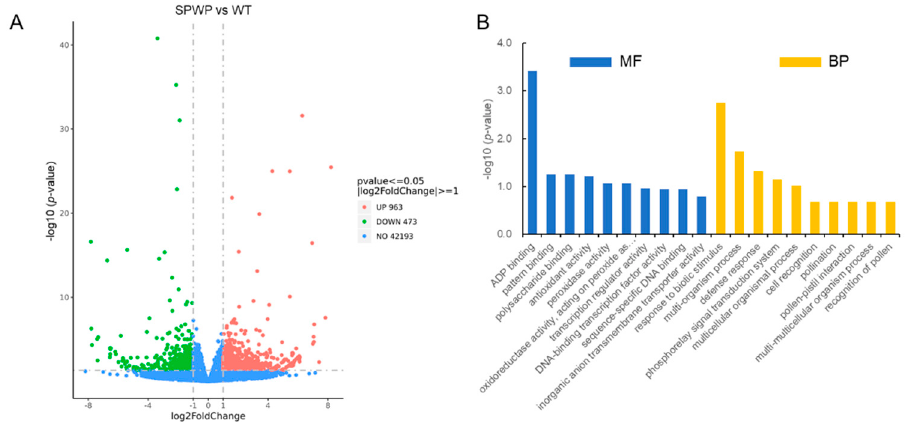
Figure 6. Differentially expressed genes (DEGs) in the spwp mutant compared with the wild-type (WT). ( A ): Volcano plot of DEGs determined by RNA-seq using the criteria p -value ≤ 0.05 and |log2 (Fold Change)| ≥ 1. Red dots indicate up-regulated genes and green dots indicate down-regulated genes. ( B ): enriched GO terms in the “molecular function” (MF) and “biological processes” (BP) categories of DEGs.